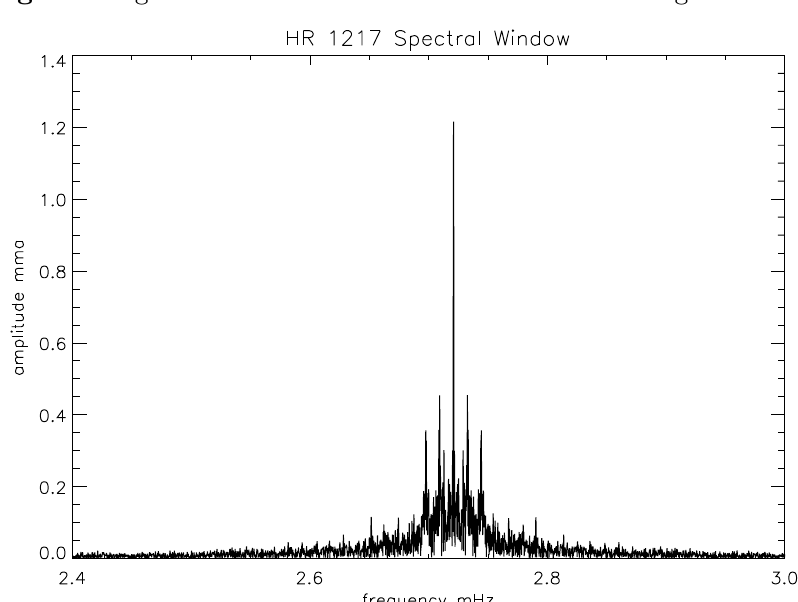
Fig. 2. A higher resolution FT of the same data as in Fig. 1.